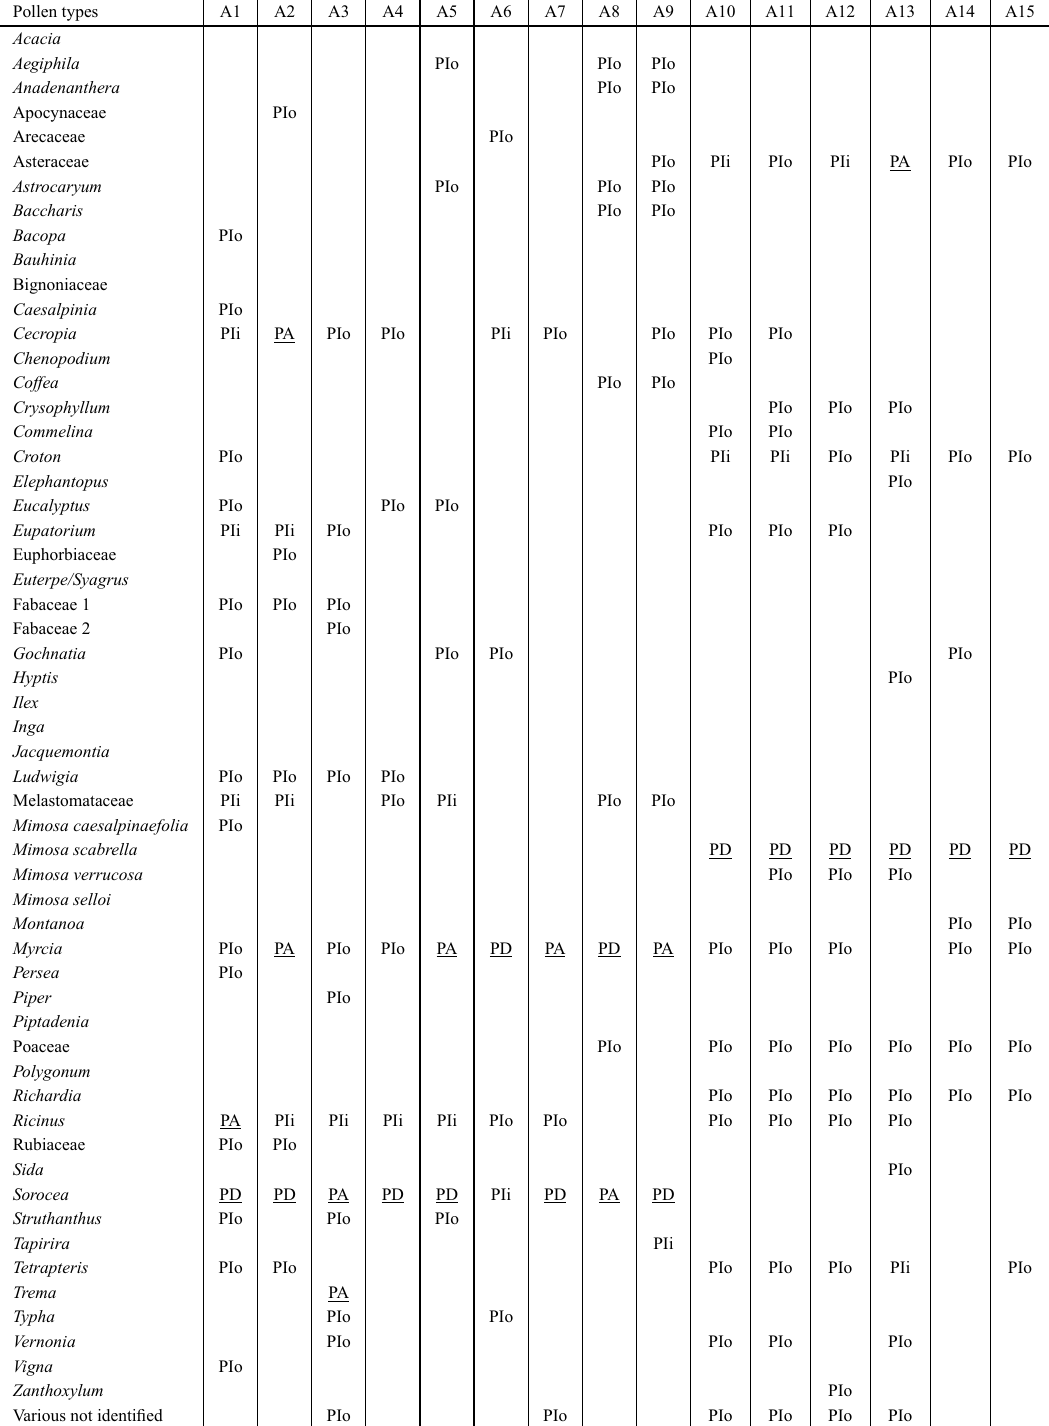
List of occurrence and frequencies of pollen types from pollen loads from beehives A and B harvested from September 2007 to March 2008, Pará de Minas, Minas Gerais State. PD = dominant pollen ( > 45 %); PA = accessory pollen (15%-45%); PIi = isolate pollen (3%-15%); PIo = occasional pollen ( < 3 %). Pollen